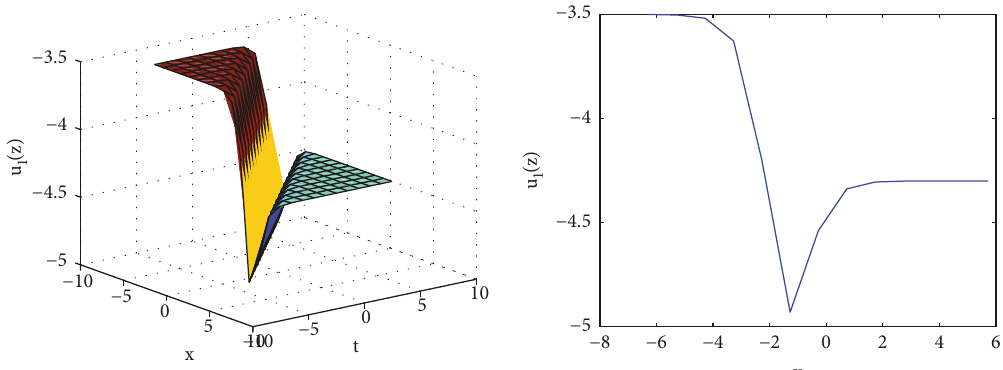
Figure 1: The 3D and 2D surfaces of 𝑢 1 (𝑧) by considering the values 𝛾 = 4 , 𝜇 = 3 , 𝑘 = 1 , 𝐿 = 1 , 𝜆 = −43 , 𝑦 = 0 , 𝑎 = 1 , and 𝑡 = 0 for the 2D graphic.